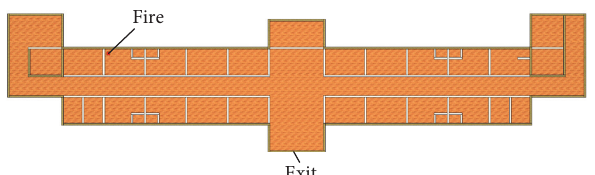
Figure 5: Building fire